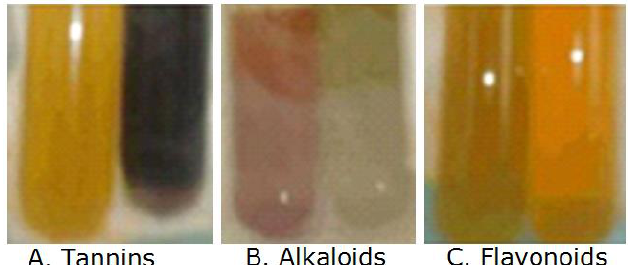
Figure 1. nucleophilic addition of amine in p -aminophenol and vanillin, forming imine group in PAPVN structure